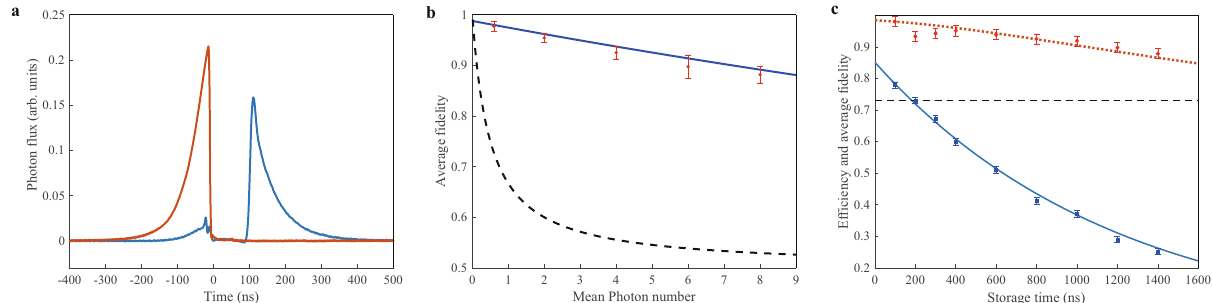
Fig. 2 Experimental results. a Temporal variation of the experimentally measured photon fl uxes. The red line and the blue line indicate the photon fl uxes of the input signal mode and the released signal mode from the cavity-enhanced quantum memory system, respectively. b The dependence of average fi delity on the mean photon number of the Gaussian distribution set of input coherent states. Blue solid line represents the theoretical average fi delity, and the red dots are the corresponding experimentally measured results. The black dashed line is the corresponding classical benchmark fi delity. c The results for memory ef fi ciency and average fi delity vs. storage time. Blue solid line and blue squares are the theoretical memory ef fi ciency and the experimentally measured values, respectively; and red dotted line and red dots represent the theoretical average fi delity and experimentally measured results, respectively; the black dashed line stands for the classical benchmark fi delity. Error bars represent ±1 standard error are obtained with the statistics of the measured photon numbers and